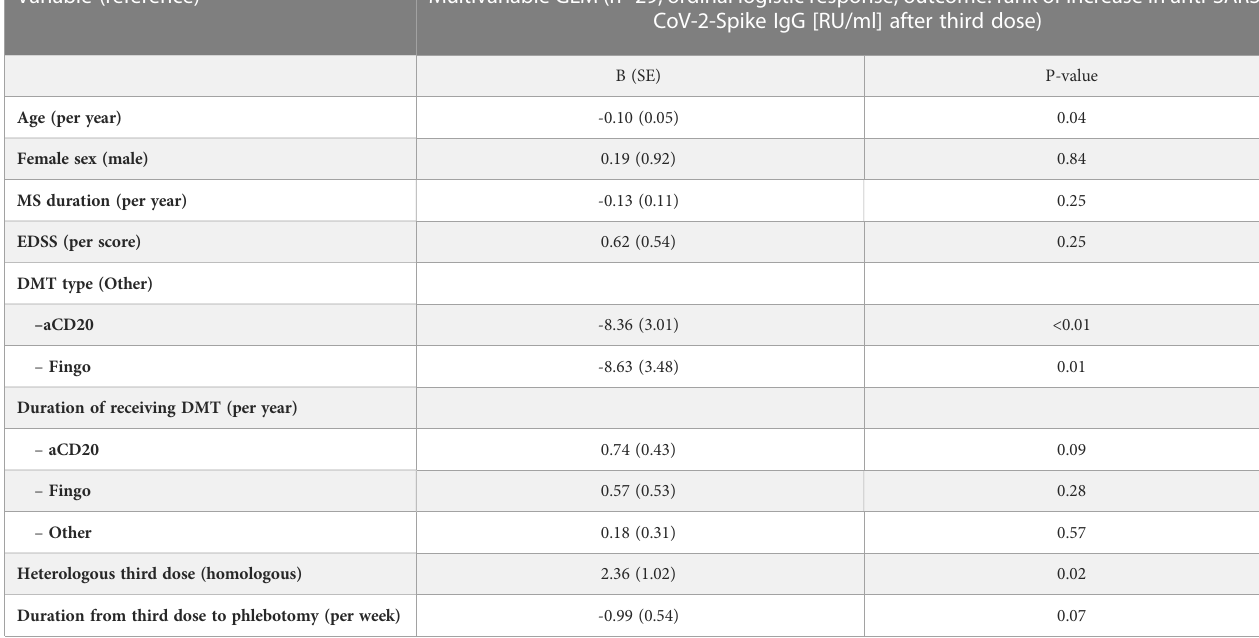
TABLE 2 Multivariable generalized linear